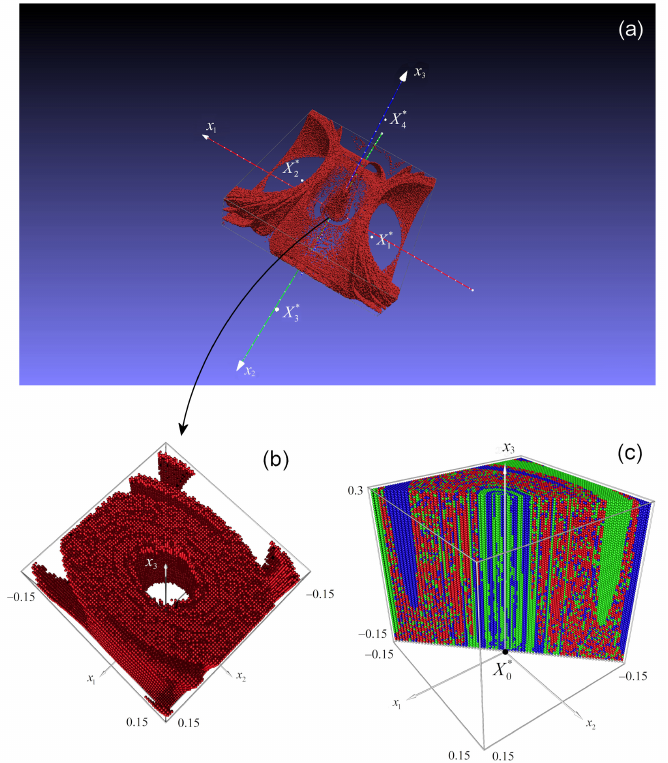
Figure 5. ( a ) Three-dimensional parallelipipedic representation of the attraction basin (red plot) of the chaotic attractor H , determined around the unstable equilibrium X ∗ the fact that there are no initial points within a small cubic neighborhood of X ∗ area presenting, as a supplement, the initial conditions leading to the stable equilibria X ∗ red